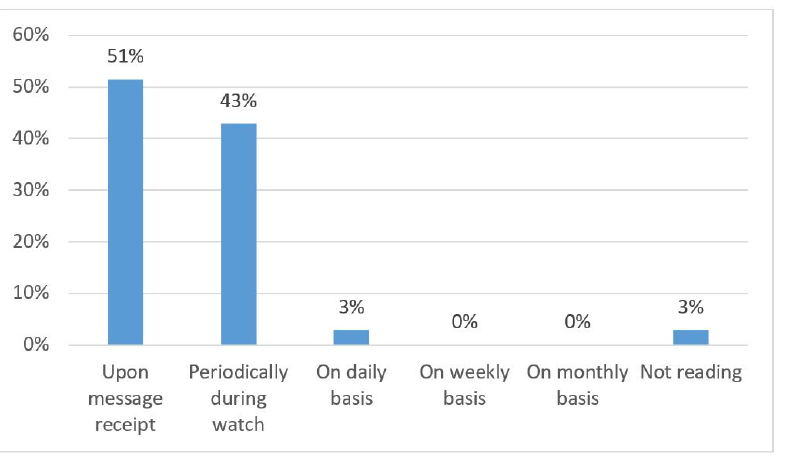
Figure 10. Frequency of use of the Enhanced Group Call (EGC) receiver.